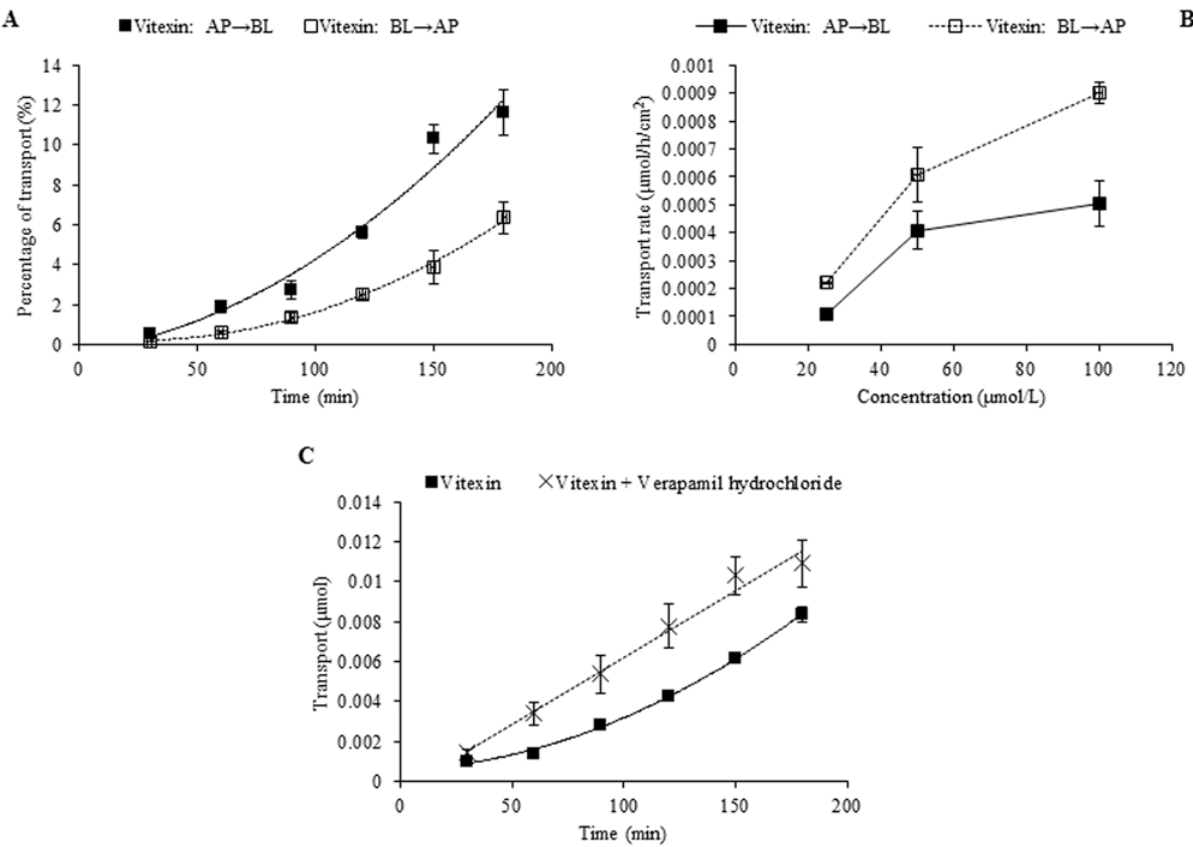
Fig 9. Transport of vitexin across Caco-2 cell monolayer. Notes: (A) The percent transport of vitexin as a function of time at 50 μ mol/L; (B) The transport rate of vitexin as a function of concentration at 90 min; (C) The effect of verapamil hydrochloride on the transport of vitexin as a function of time at 50 μ